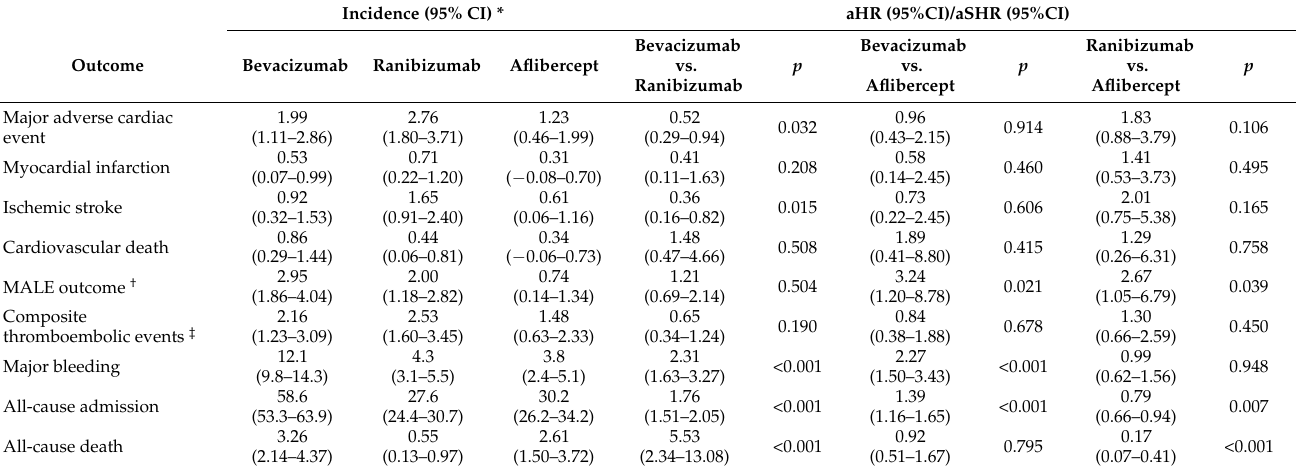
Table 2. Time to event outcome analysis in 6 months after inverse probability of treatment weighting. Incidence (95% CI)